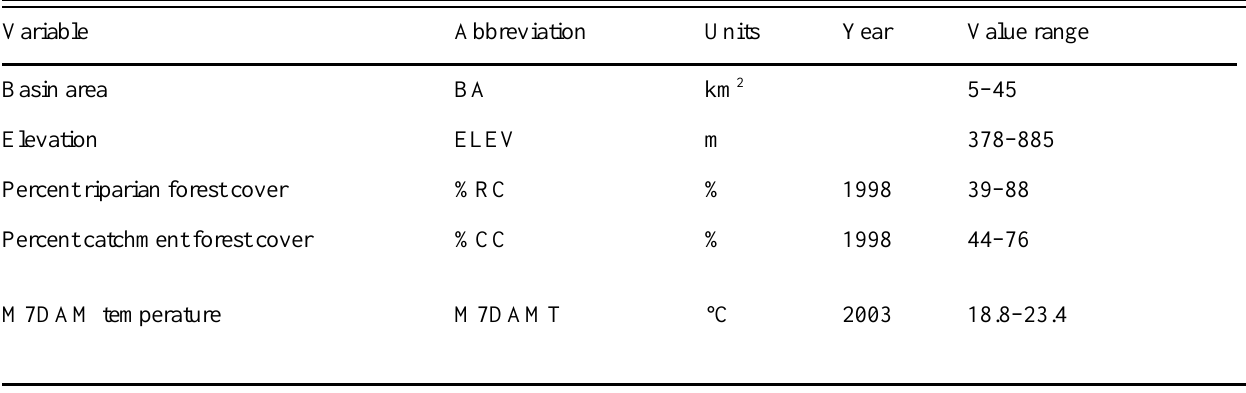
Table 4. Landscape and stream temperature variables measured for supplemental sampling sites ( n =